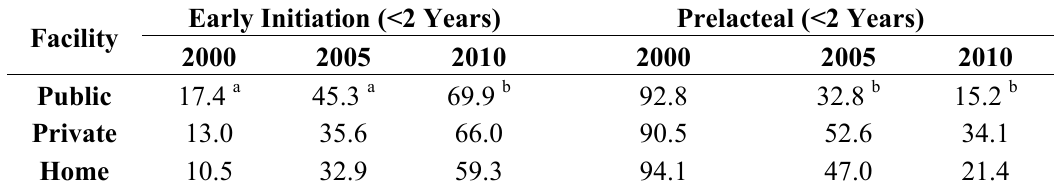
Table 1. Early initiation of breastfeeding and pre-lacteal feeding by place of delivery, Cambodia Demographic Health Survey (CDHS) 2000–2010 *.